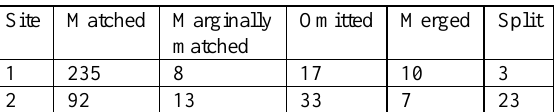
Table 2: The accuracy statistics of the delineation tree crowns using Residual U-net for test sites 1 and 2. The total number of reference crowns are 273 and 168 for these two sites, respectively.